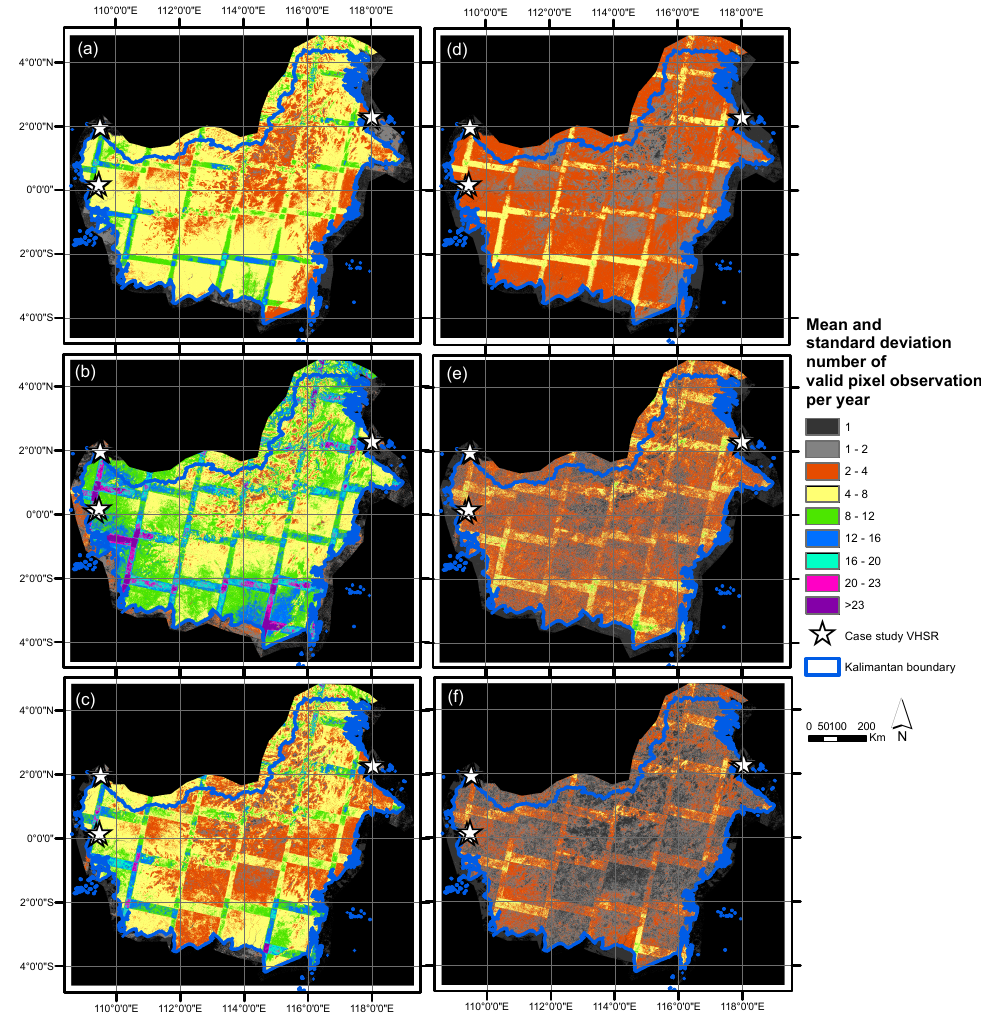
Figure 3. Per-pixel mean ( a – c ) and standard deviation ( d – f ) number of cloud-free observations per year during ( a , d ) 1999–2012 from TM and ETM+ sensors, ( b , e ) 2013–2016 from ETM+ and OLI, and ( c , f ) 2013–2016 from OLI alone, in the mega-island of Kalimantan. White star symbols denote the location of the six case study (reference) VHSR scenes. Note the observation counts are binned as 1, (1, 2], (2, 4], (4, 8], ..., (23,